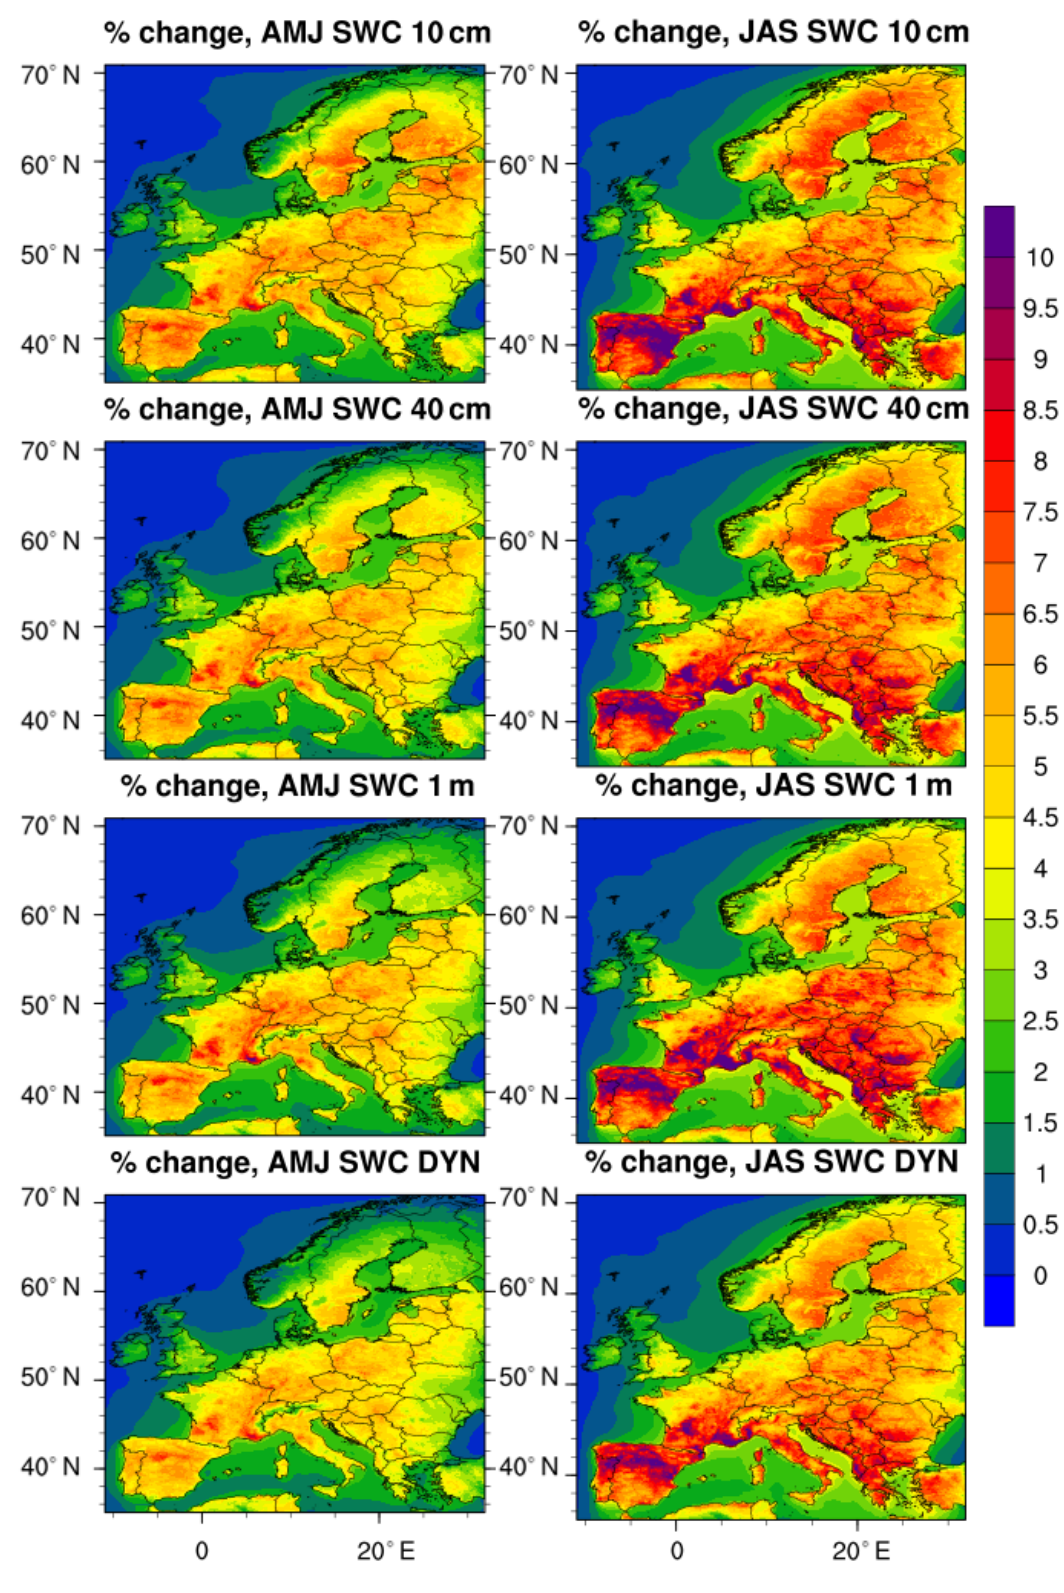
Figure 4. Percentage change in surface O 3 concentration (absolute values are given in Fig.